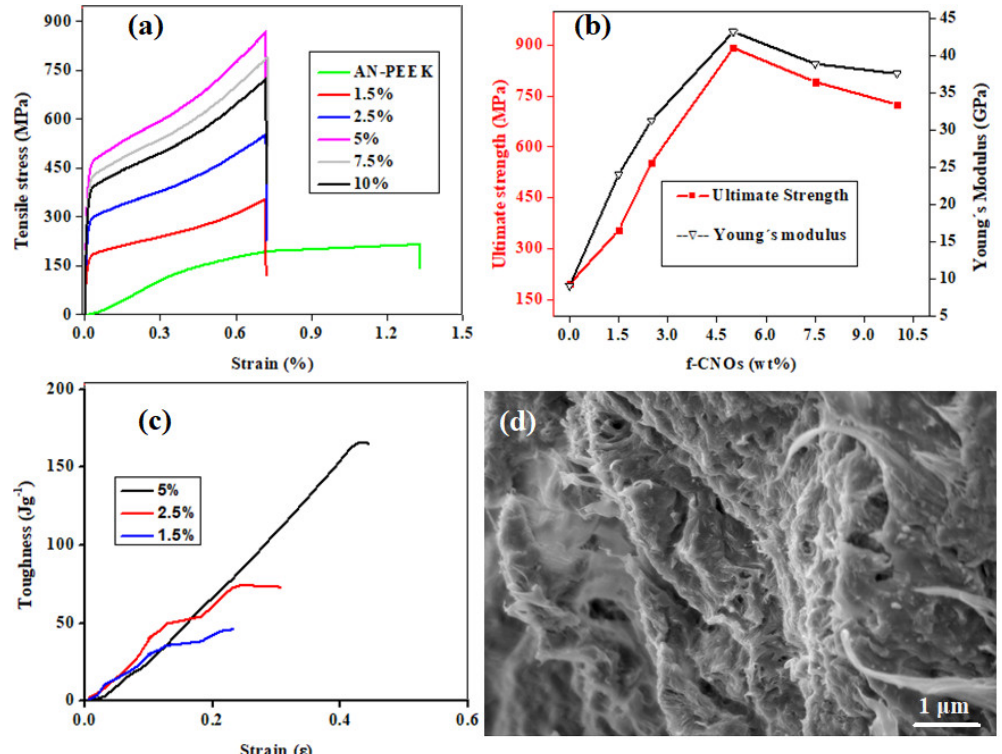
Figure 3. Quantitative mechanical characterization of AN-PEEK/f-CNOs composite films. ( a ) Stress–strain, ( b ) ultimate strength-Young´s modulus, ( c ) toughness-strain curves for nanocomposite thin films obtained from uniaxial tensile. ( d ) SEM images of fracture surfaces of AN-PEEK/f-CNOs with 5 wt% of f-CNOs, prepared from tearing tests on notched samples. The weight fraction in the x-axis ( b ) and the percentage in plots ( a , c ) represent the wt% of f-CNOs content in the AN-PEEK.